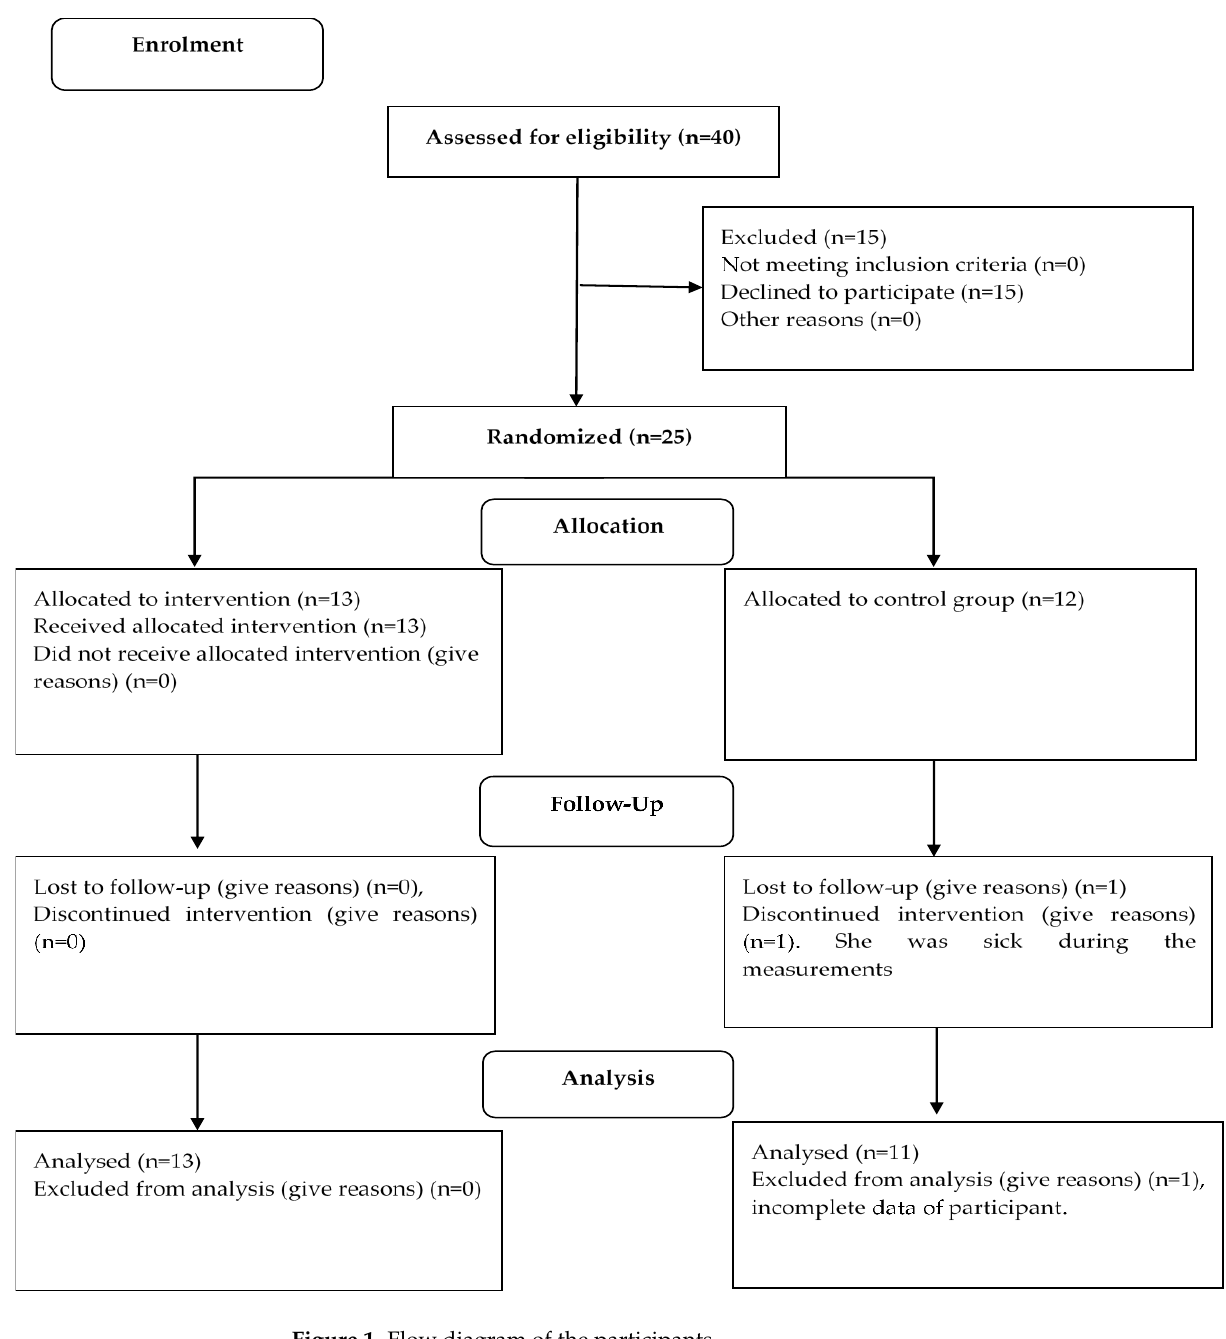
Figure 1. Flow diagram of the participants.